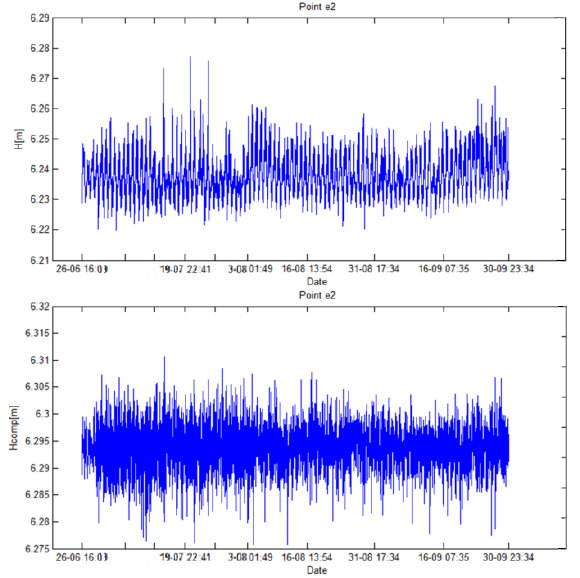
Figure 12. Raw and corrected values of height for point e2 (values are referenced to the station)